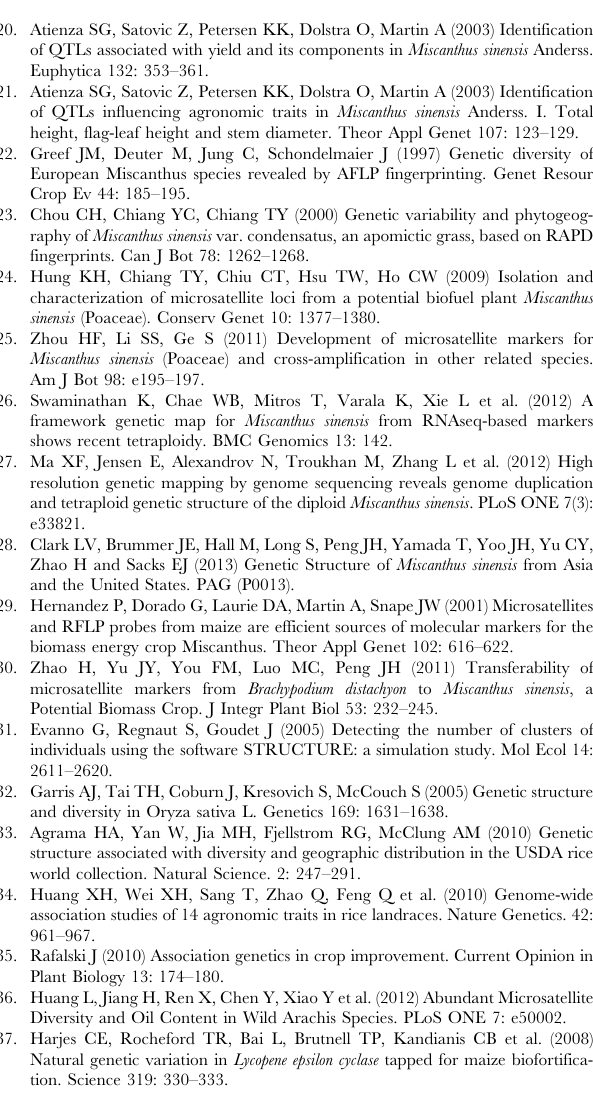
Table S2 Geographical parameters and the group information for M. sinensis germplasm accessions. Table S2 Primer sequences, optimal annealing temperature (AT), number of polymorphic bands (NB) and chromosome location on the B. distachyon for each primer pair.